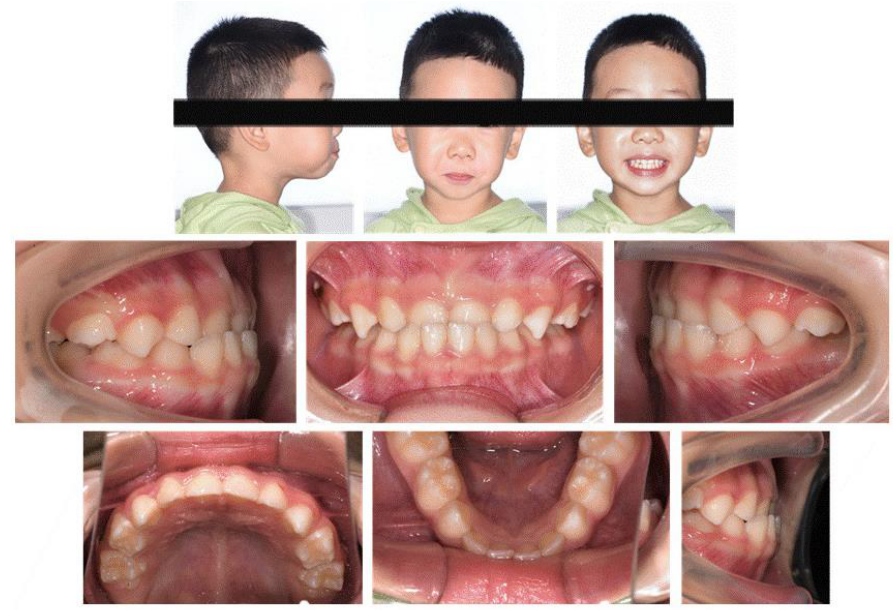
Figure 1. Initial photographs.